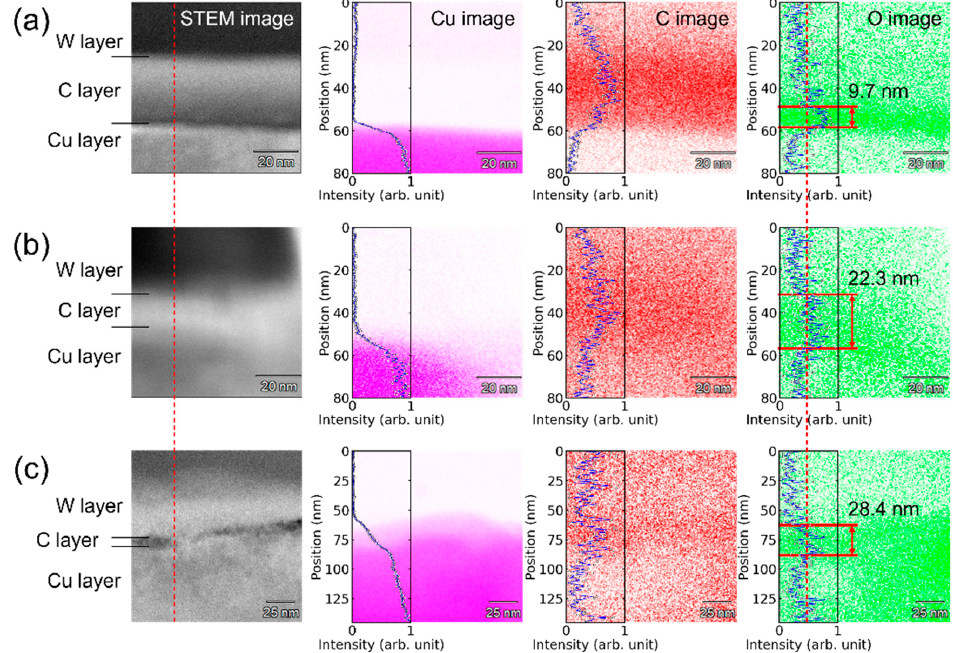
Figure 4. STEM images (cross ‐ sectional view), Cu, C, and O mappings of ( a ) pristine, ( b ) 50 mW ‐ irradiated, and ( c ) 100 mW ‐ irradiated Cu surfaces. The red dotted line in the O image indicate the half maximum of the normalized intensity.